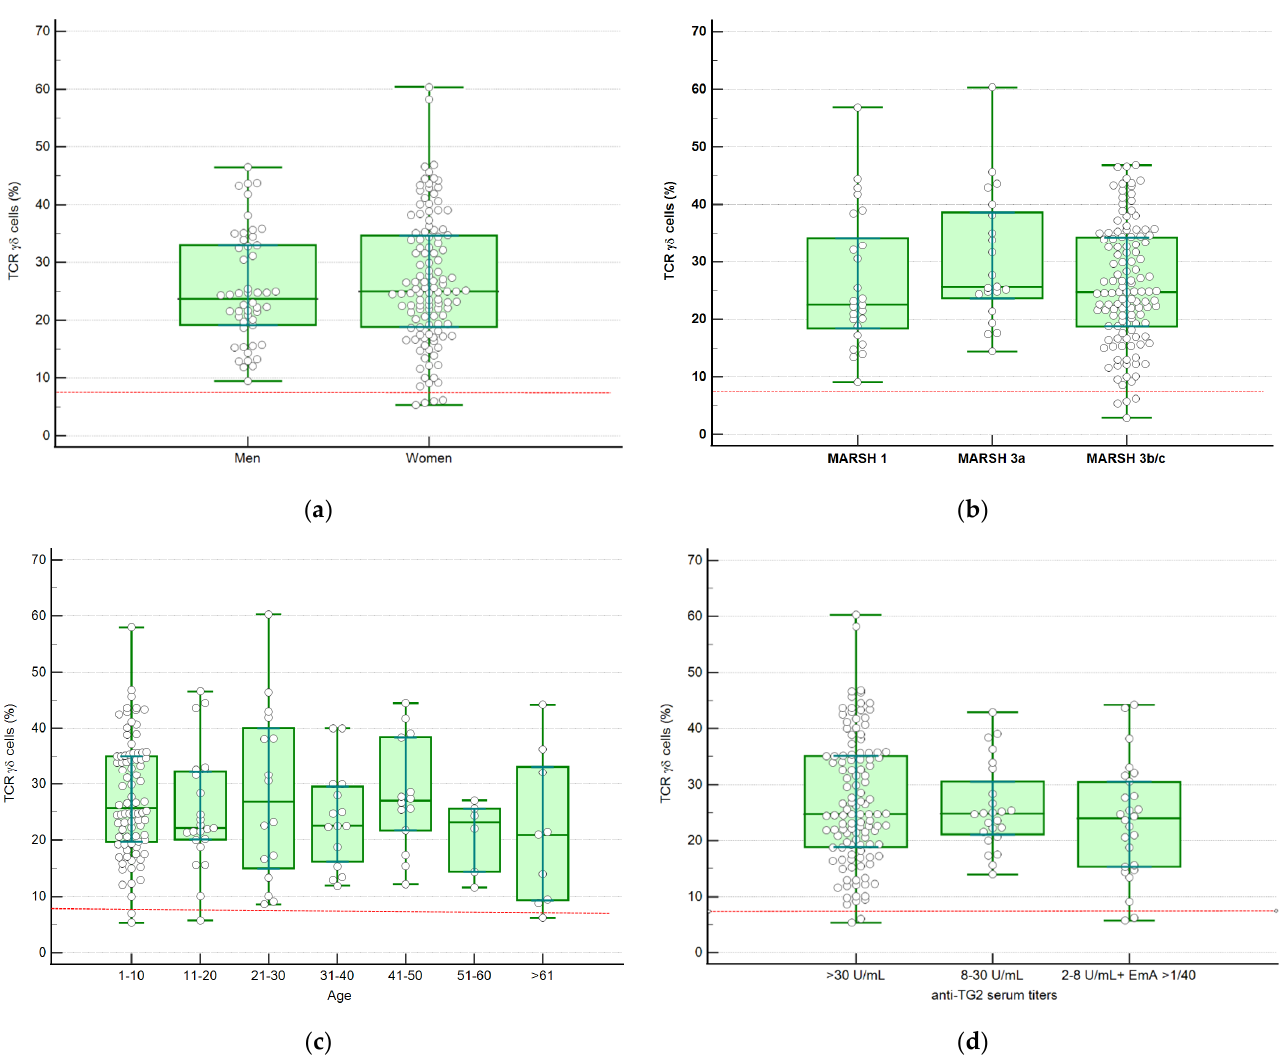
Figure 2. Scatter plot and box-whisker showing the distribution of patients according to sex ( a ), degree of histological lesion ( b ), age ( c ), and anti-TG2 serum titers ( d ). Box-plot rectangle spans the interquartile range, the segment inside the rectangle shows median whereas the whiskers above and below plot, the maximum and the minimum. The dotted red line represents the stablished TCRγδ + cut-off (>8.5%).